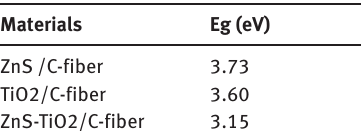
Figure 7: Tauc plots of (a) TiO and (d)